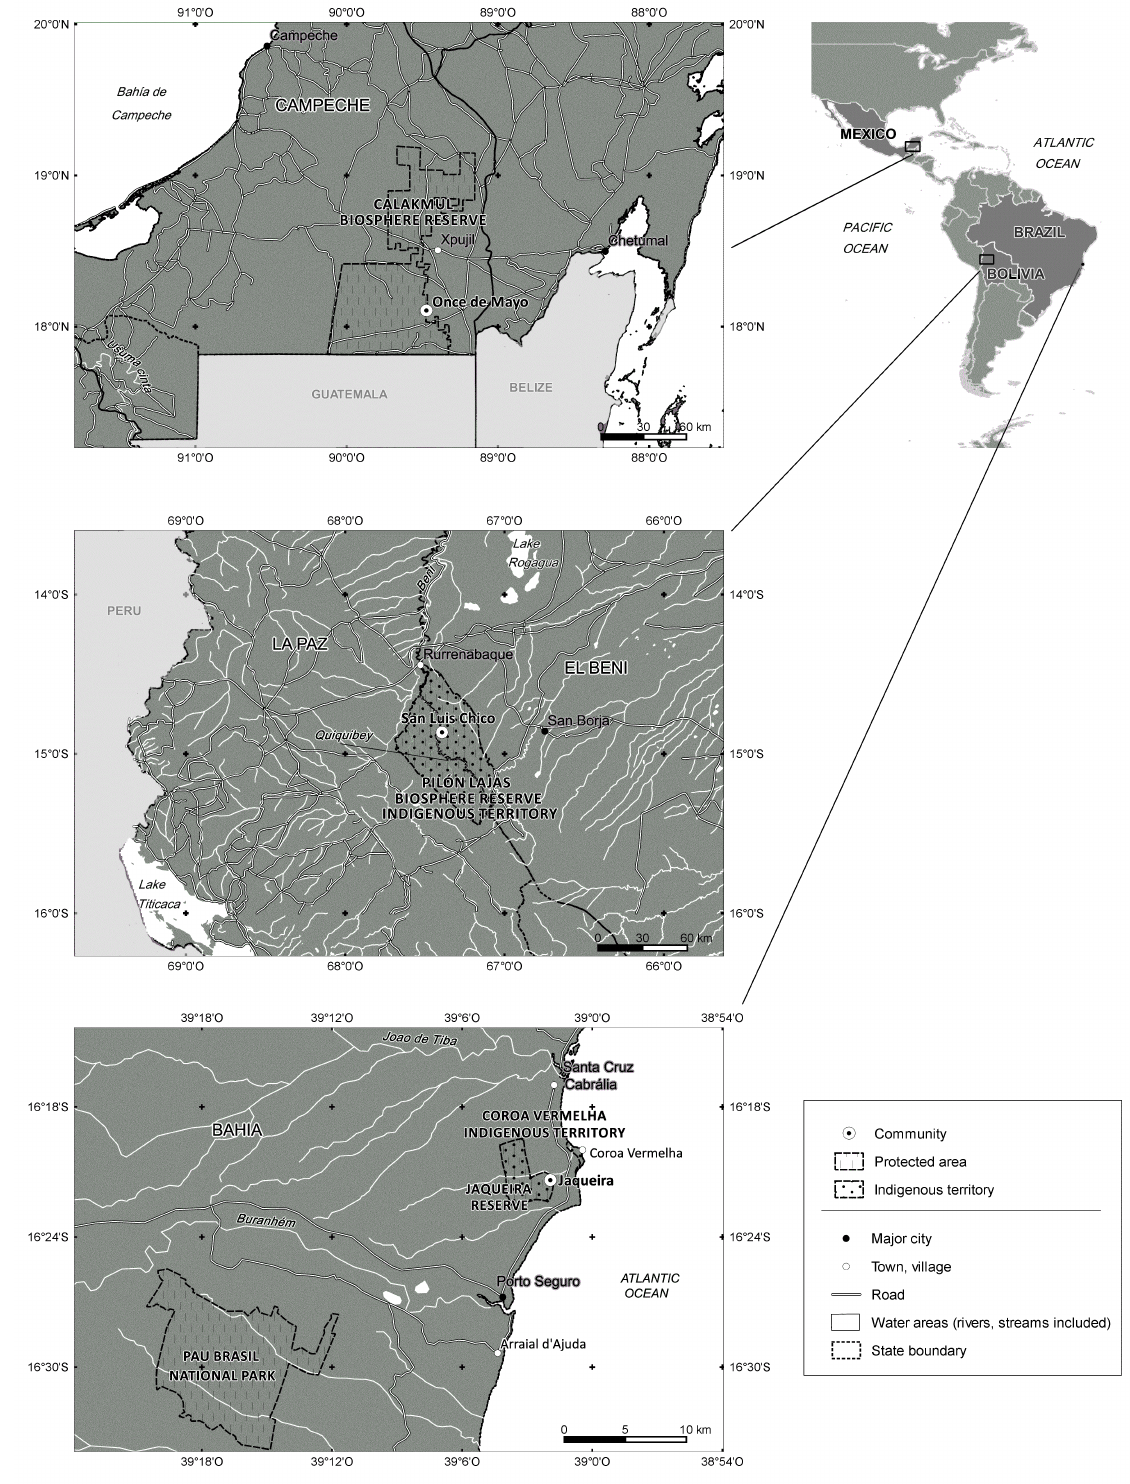
Fig. 1 . Studied communities involved in community-based conservation in Brazil, Mexico, and